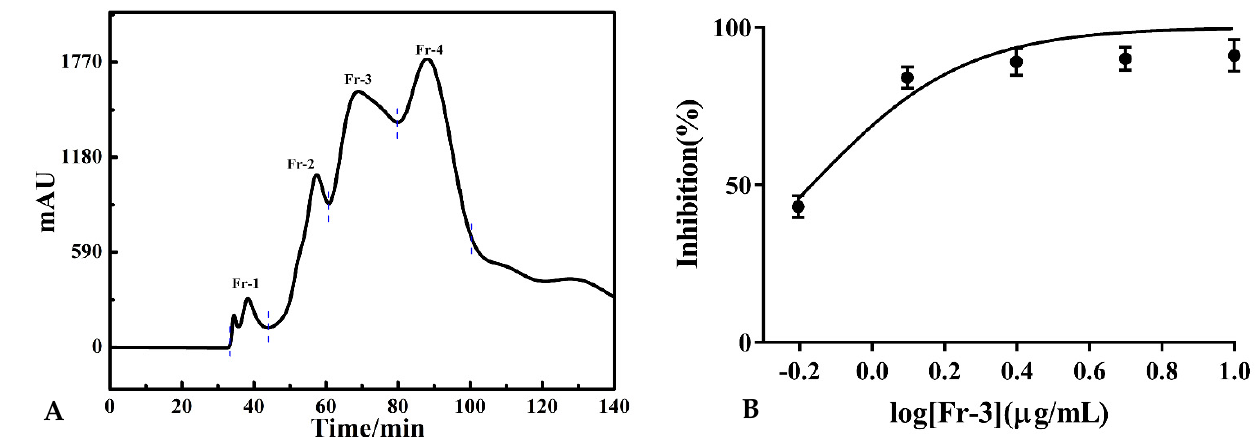
Figure 1. Pretreatment chromatogram of ethanol extract of P. hookeri with MCI medium-pressure chromatographic tower ( A ); The dose-response curves and IC 50 value of Fr-3 ( B ).